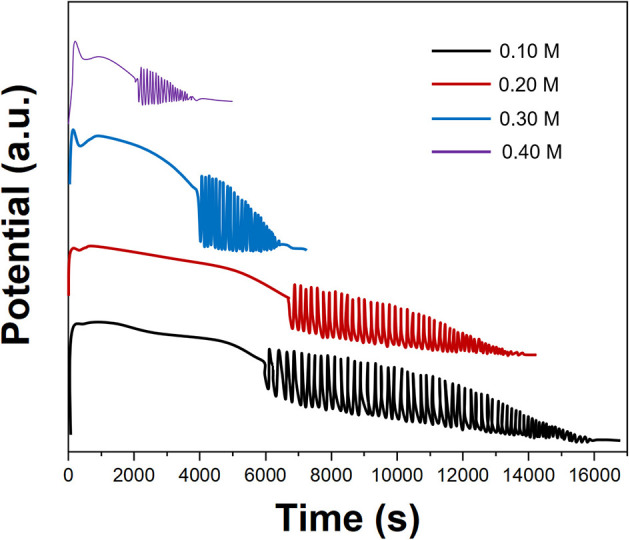
Oscillating profiles of Prunus persica recorded using different concentrations of KBrO3.